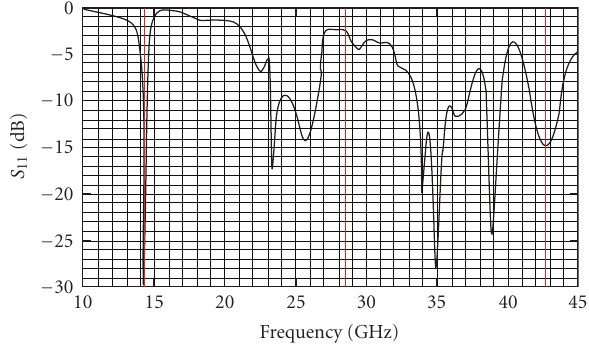
Figure 1: Curves of the resonant frequencies of the modes of the CDRA under analysis, as a function of resonator height having let radius to vary so that the first resonance remains fixed at 14 . 25 GHz.